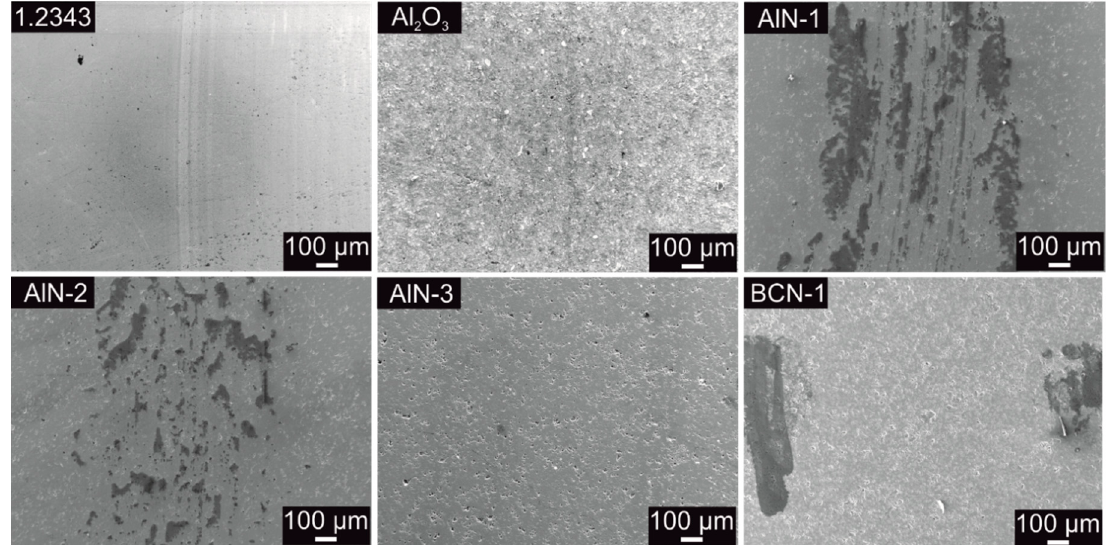
Figure 6. SEM images of the different surfaces after the Ball-on-Disc experiments at 85